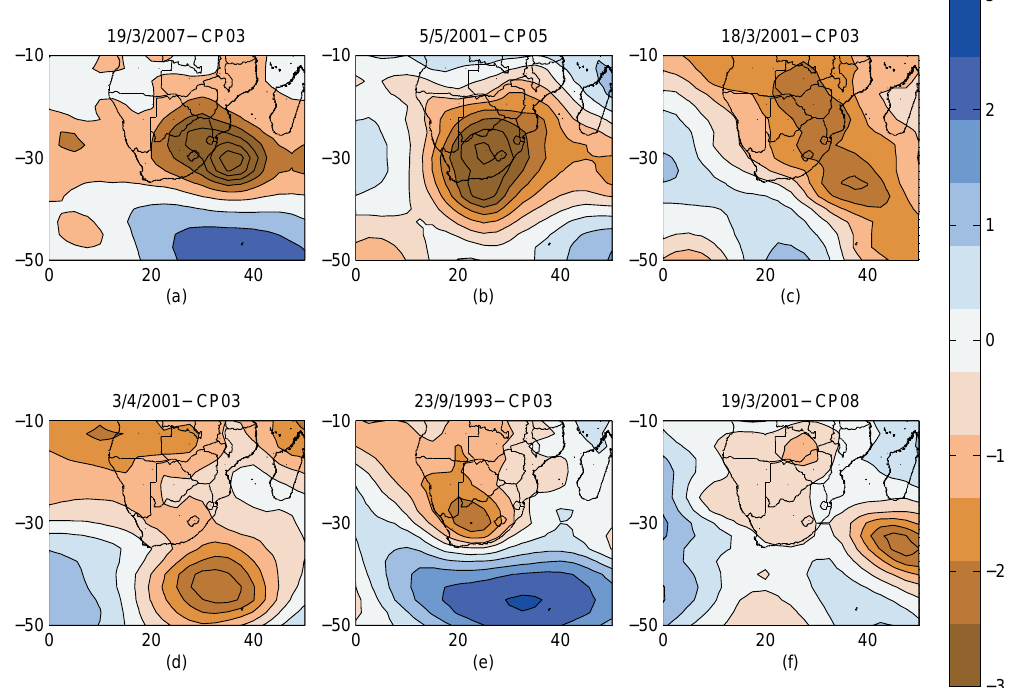
Figure 5. CPs associated with the six largest significant wave heights for the dates (a) 19 March 2007, (b) 5 May 2001, (c) 18 March Fig. 5. CP’s associated with the six largest significant wave heights for the dates (a) 19/3/2007, (b) 5/5/2001, (c) 18/3/2001, (d) 3/4/2001, (e) 23/9/1993 and (f) 19/3/2001.